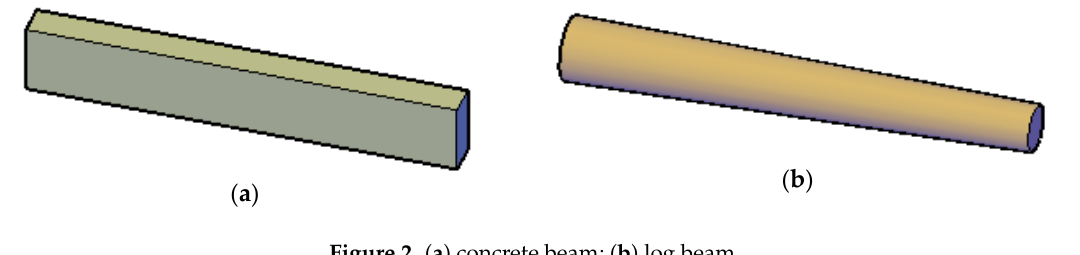
Figure 2. ( a ) concrete beam; ( b ) log beam.